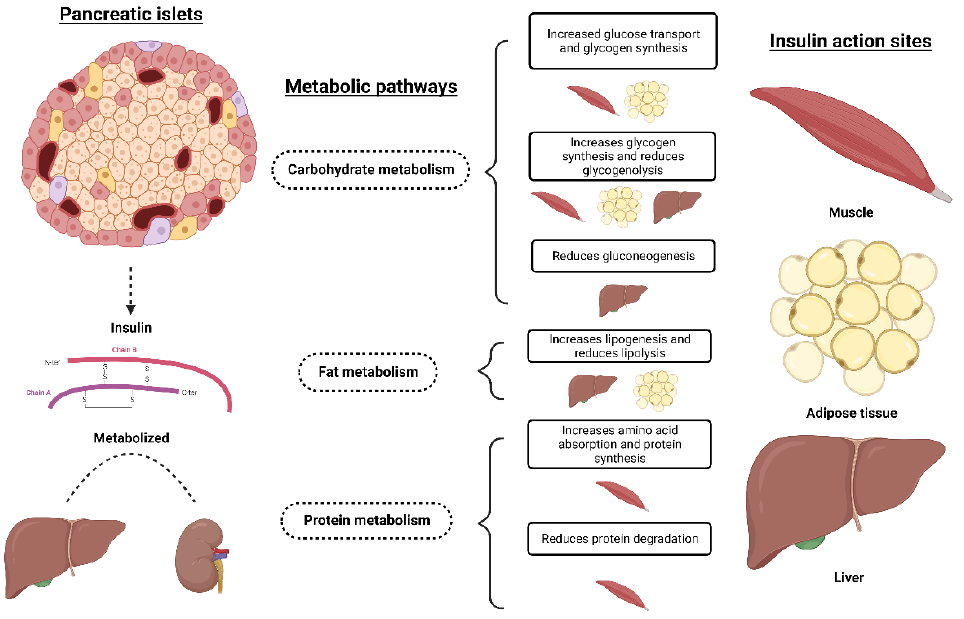
Figure 1. Influence of insulin action on different metabolic pathways and sites of action. Created with BioRender.com.